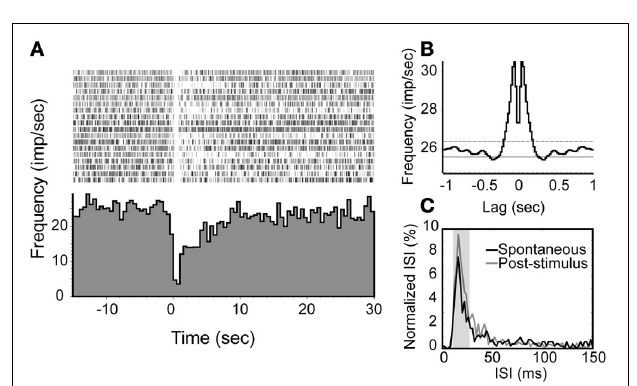
FIGURE 7 | Effects of stimulation and scopolamine on a respiration-synchronized rhythmic unit. (A) A time course spiking recording shows the effects of NDB stimulation (100 μ s, 400 μ A, 100Hz, 25 pulses) and scopolamine (IP, 5mg/kg). Note this unit does not show recovery during the course of recording. The dashed line indicates the start time of scopolamine. (B) An autocorrelation analysis reveals the unit rhythmicity at 3Hz (Bin = 20ms). (C) Histogram of NDB-induced spike rates before and after scopolamine. (D,E) ISI distributions show effects before or after scopolamine treatments,